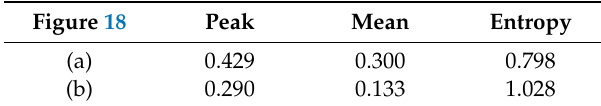
Table 13. Results of MPSM jamming in Figure 18. Figure